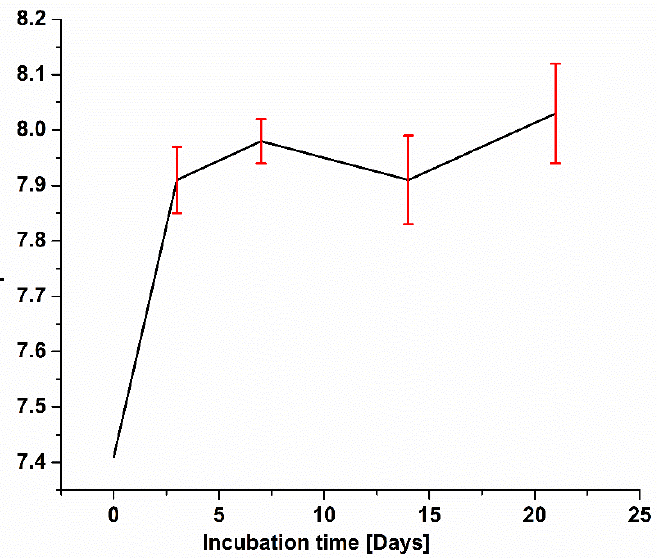
Figure 10. The difference in pH value of SBF after immersion of Ag-Sr MBGNs. pH measured at different time points from 0 to 21 days (the error bar indicates mean ± standard deviation for three individual experiments).